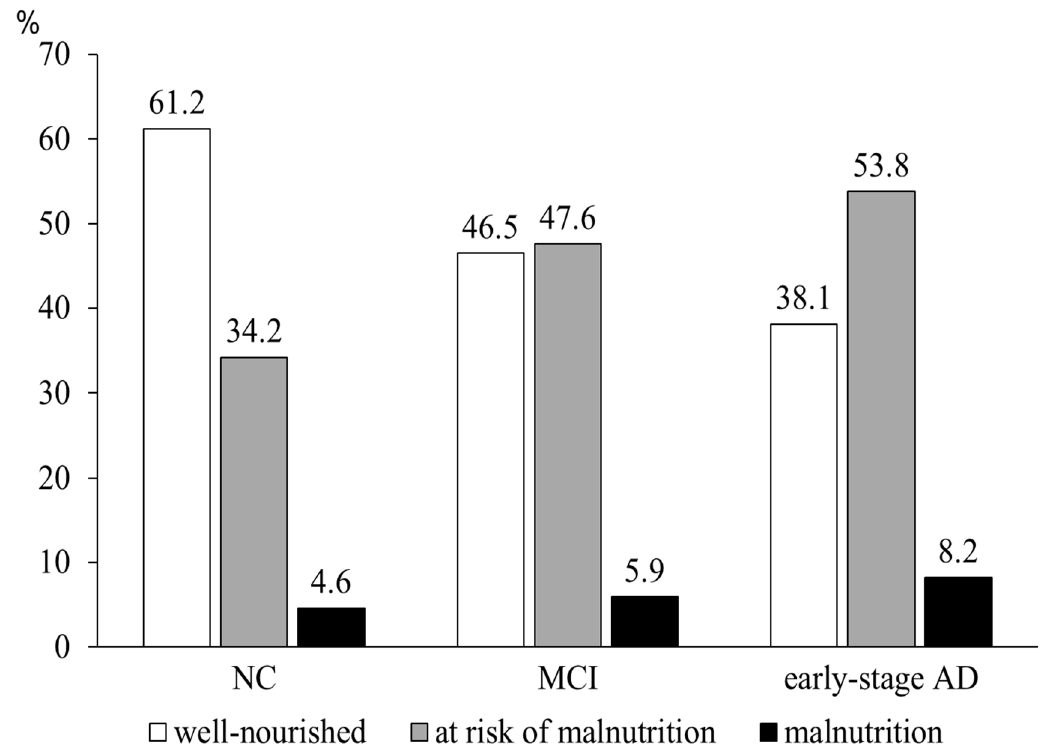
Figure 1. The prevalence of subjects at risk of / with malnutrition at various cognitive stages.